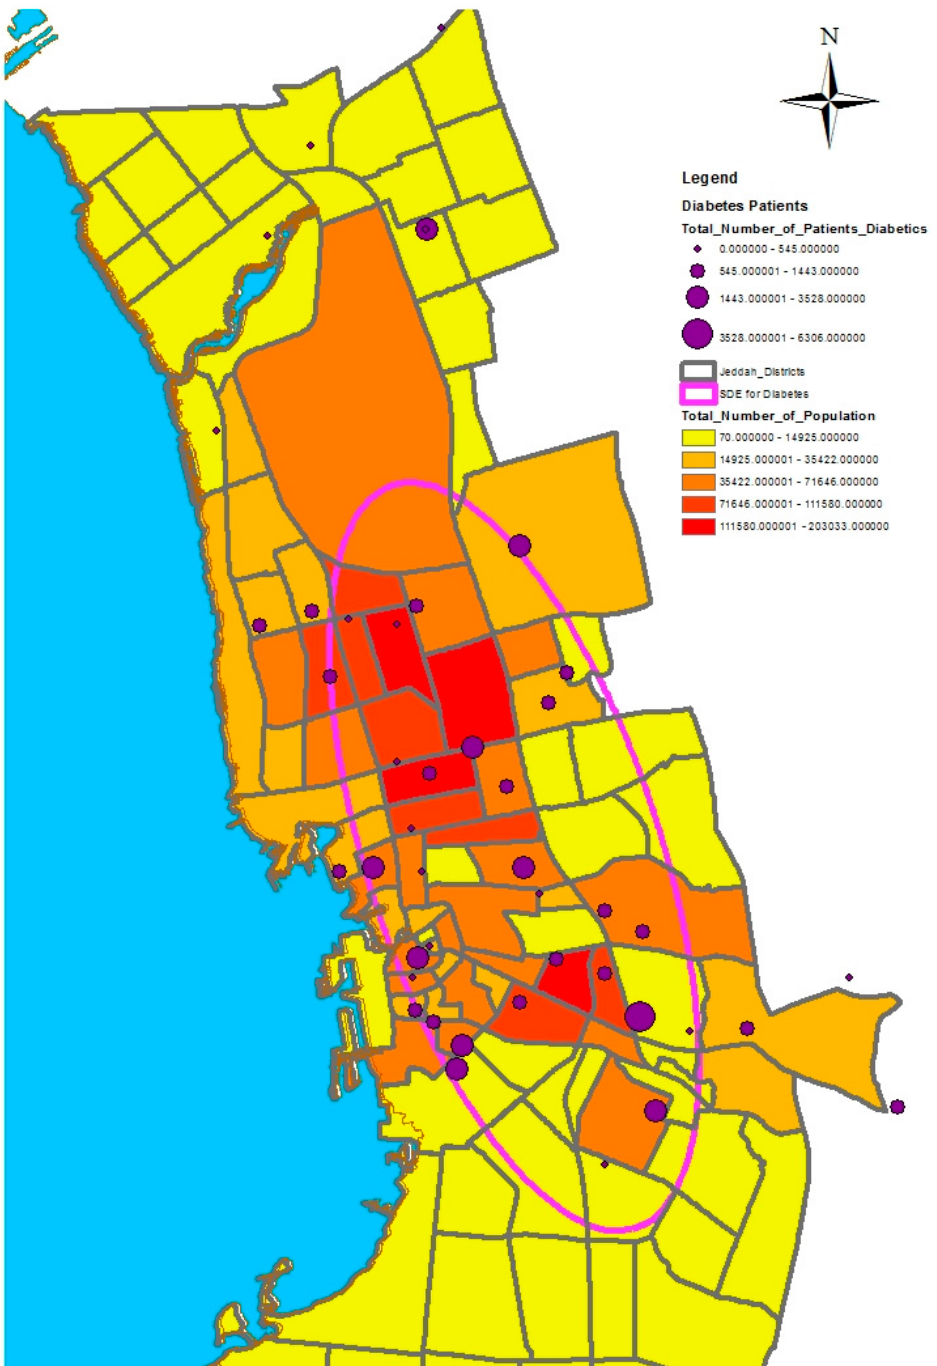
Figure 6. Standard deviational ellipses for diabetes patients.